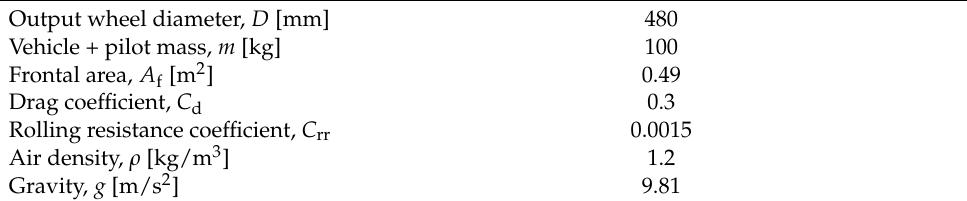
Table 1. Operational and physical characteristics of the vehicle. Output wheel diameter, D